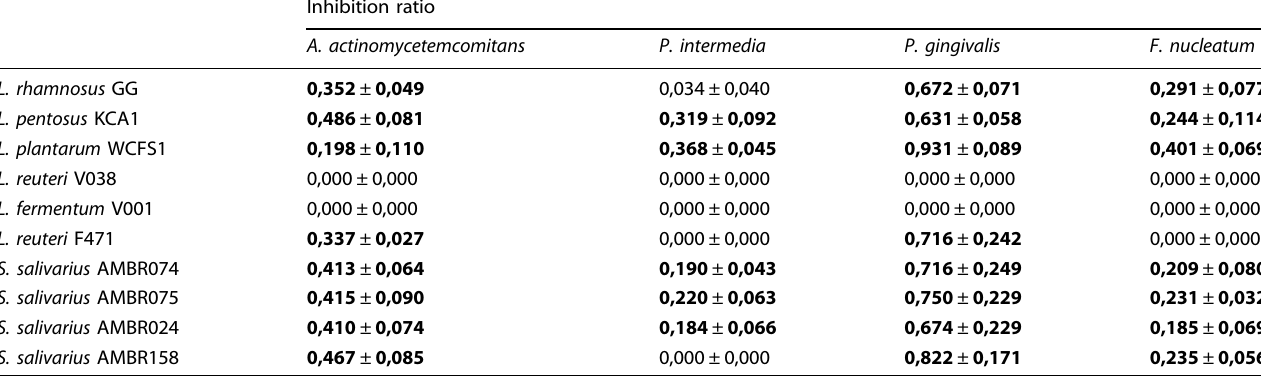
Table 1. Inhibition of pathobiont growth on agar next to probiotic